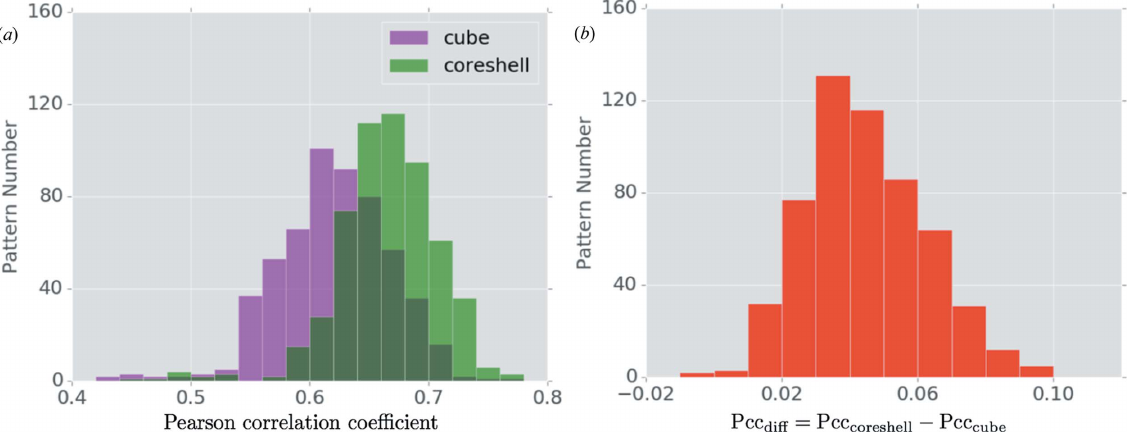
Figure 8 Comparisons between the experimental patterns and two sets of theoretical models. ( a ) The distributions of Pearson correlation coefficients between the experimental and reference models. The green bars show the results with the core–shell model as reference, and the magenta bars are the results using the cubic model (without an octahedral core). ( b ) Histogram of Pearson correlation coefficient (Pcc) difference between the experimental patterns and the best matched patterns from the core–shell and cube reference models. Only two out of 559 patterns favor the cube model over the core–shell model.